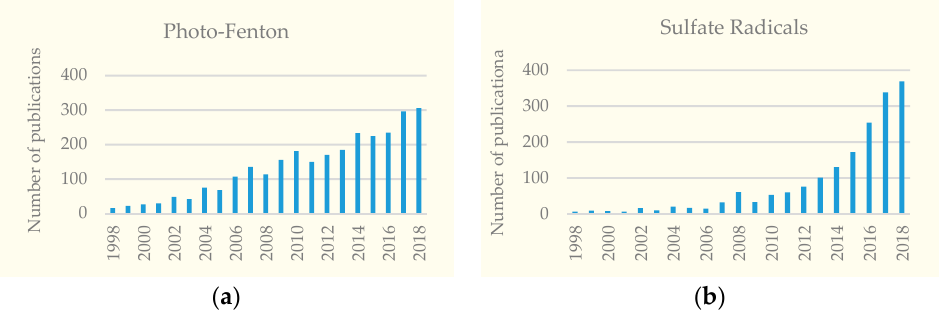
Figure 1. Number of papers published on ( a ) photo-Fenton and ( b ) sulfate radicals (applicated to advanced oxidation) on the database Scopus.